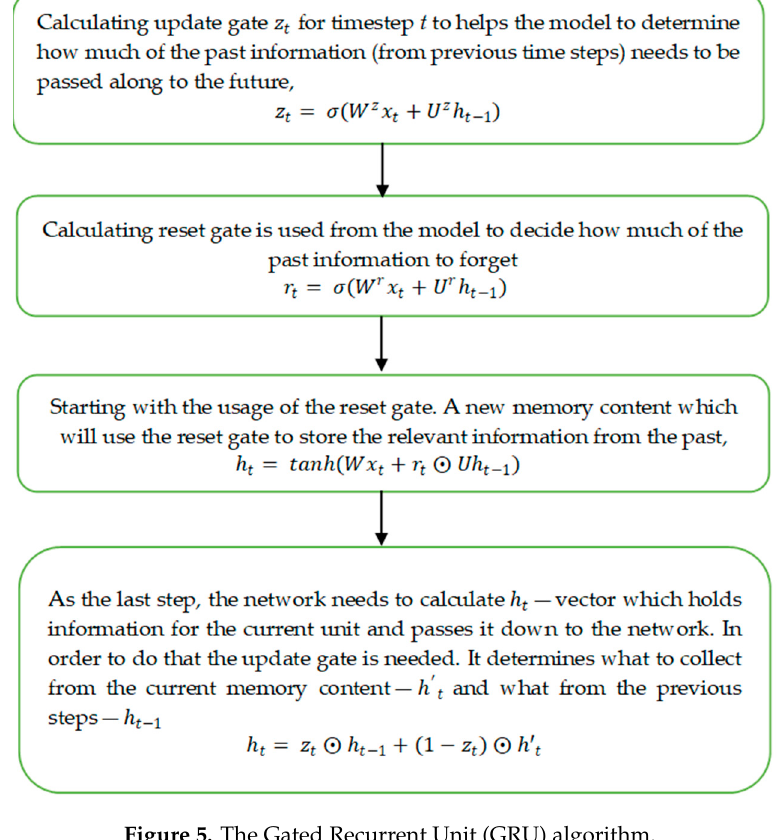
Table 1. The Hidden State in Sequence Modeling Classifier.